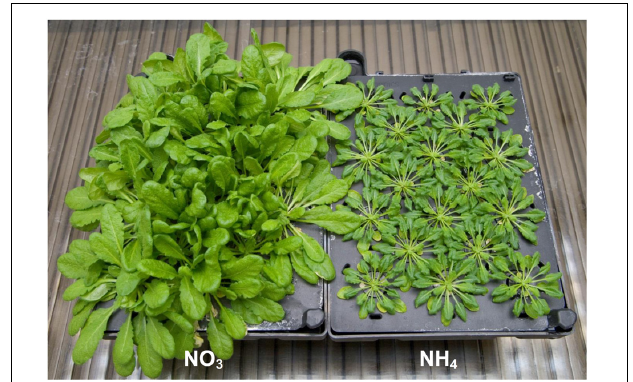
FIGURE 1 | Arabidopsis thaliana (ecotype Columbia-0) plants cultured hydroponically for 8 weeks with an 8-h photoperiod on nutrient medium containing 5 mM NO 3 − (NO 3 ) or 5 mM NH 4 + (NH 4 ) as a sole nitrogen source. Plants grown on NH 4 + showed severe growth retardation as compared